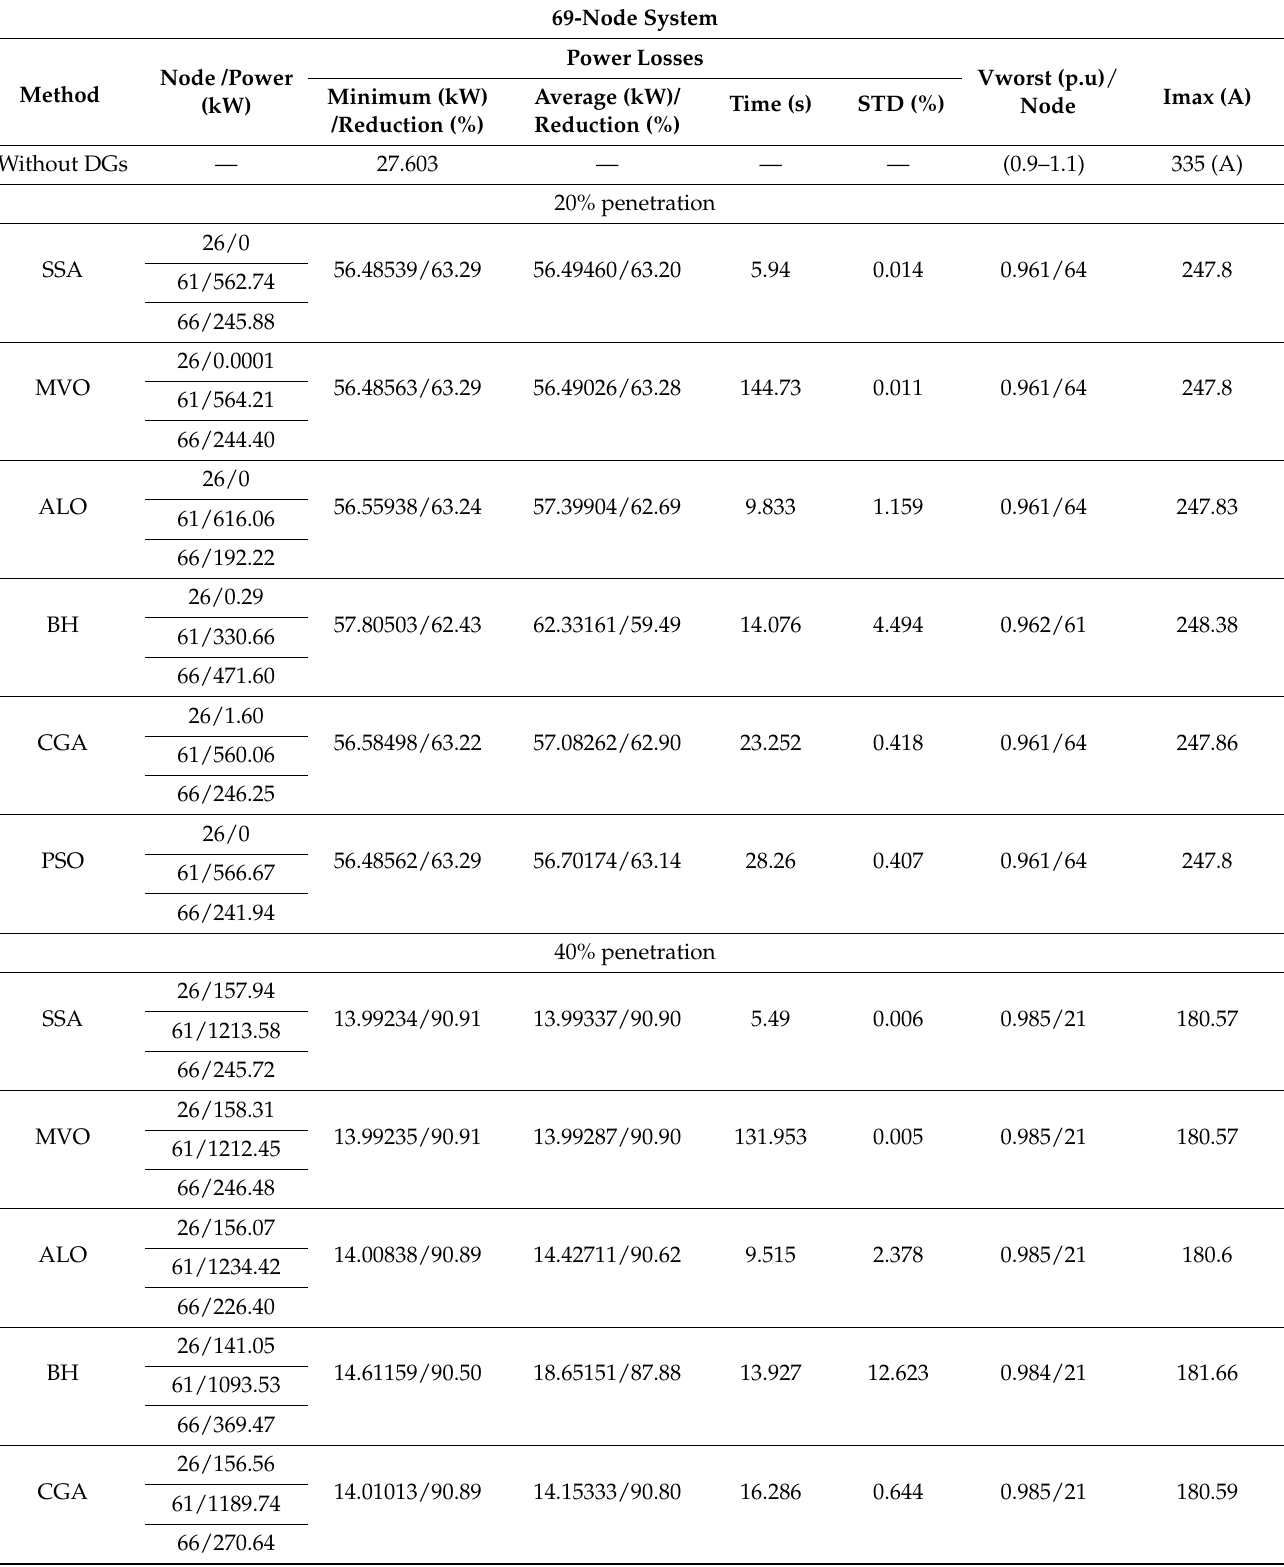
Table 7. Results of the simulations of the 69-node system 69-Node